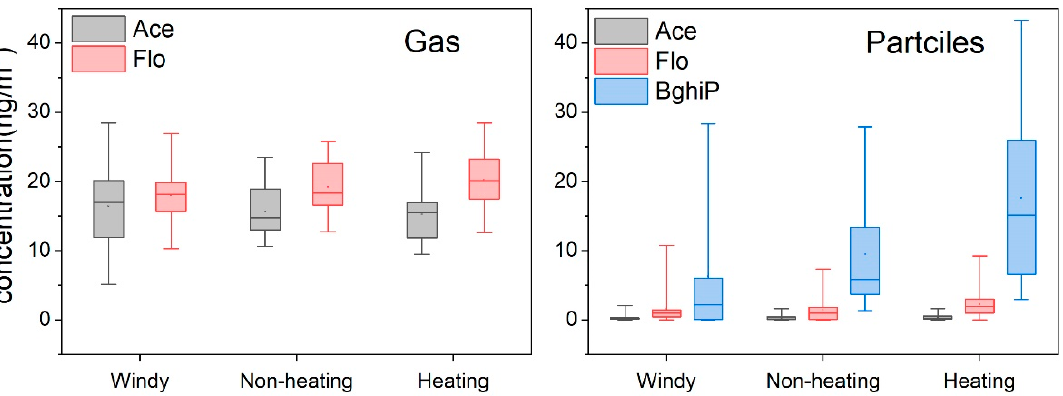
Figure 2. Statistical comparison of PAHs concentration (ng/m 3 ) between gas and particle phases in the atmosphere. The squares represent means, and the solid lines represent median values. Boxes enclose the interquartile range, and whiskers show the full range. The upper and lower limits of the box plots represent the divergence of the sites, and the inter-site concentration varied over time. Overall, the differences in gas-phase spatial